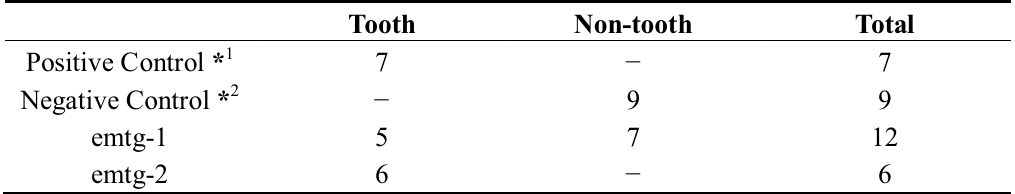
Table 4. Tissues grown from tooth germs reconstructed with emtg (1 to 5) cells and EC (E16.5) and MT (E16.5) on culture inserts; emtg cell : EC =